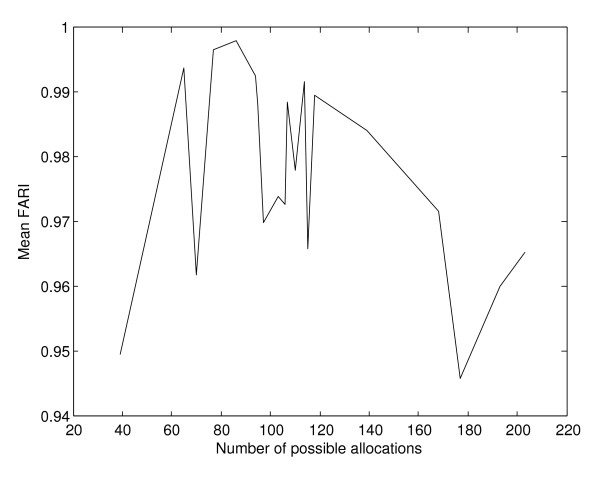
Mean FARI between allocations, according to number of possible genes to pathways allocations, for module algorithm. FARI values between allocations produced by subsequent runs of the method exhibit no correlation whatsoever to the size of the search space, as defined by the number of possible multi-membership genes' allocations.